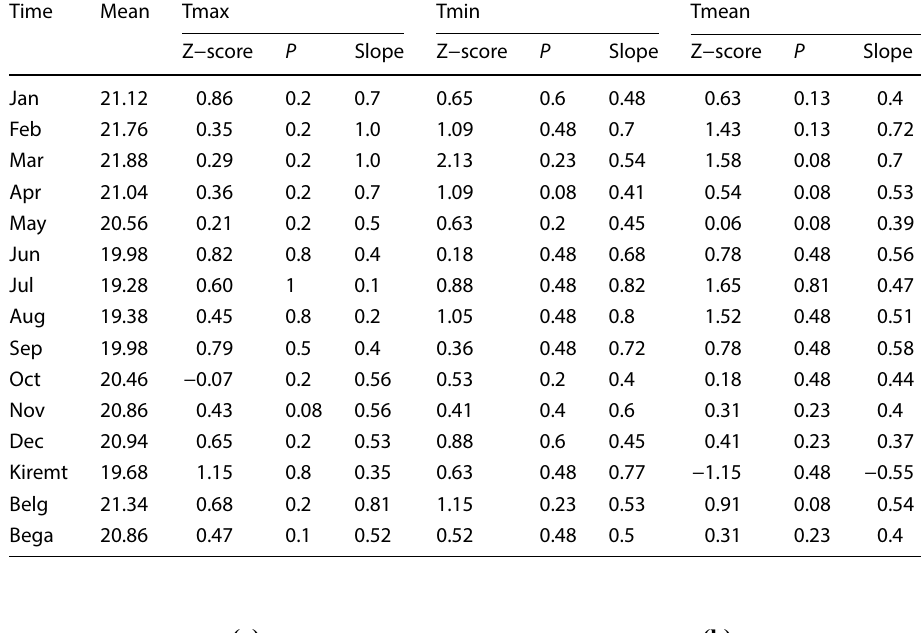
Fig. 8 a Mean monthly maxi- mum and b Mean monthly minimum temperature of the watershed